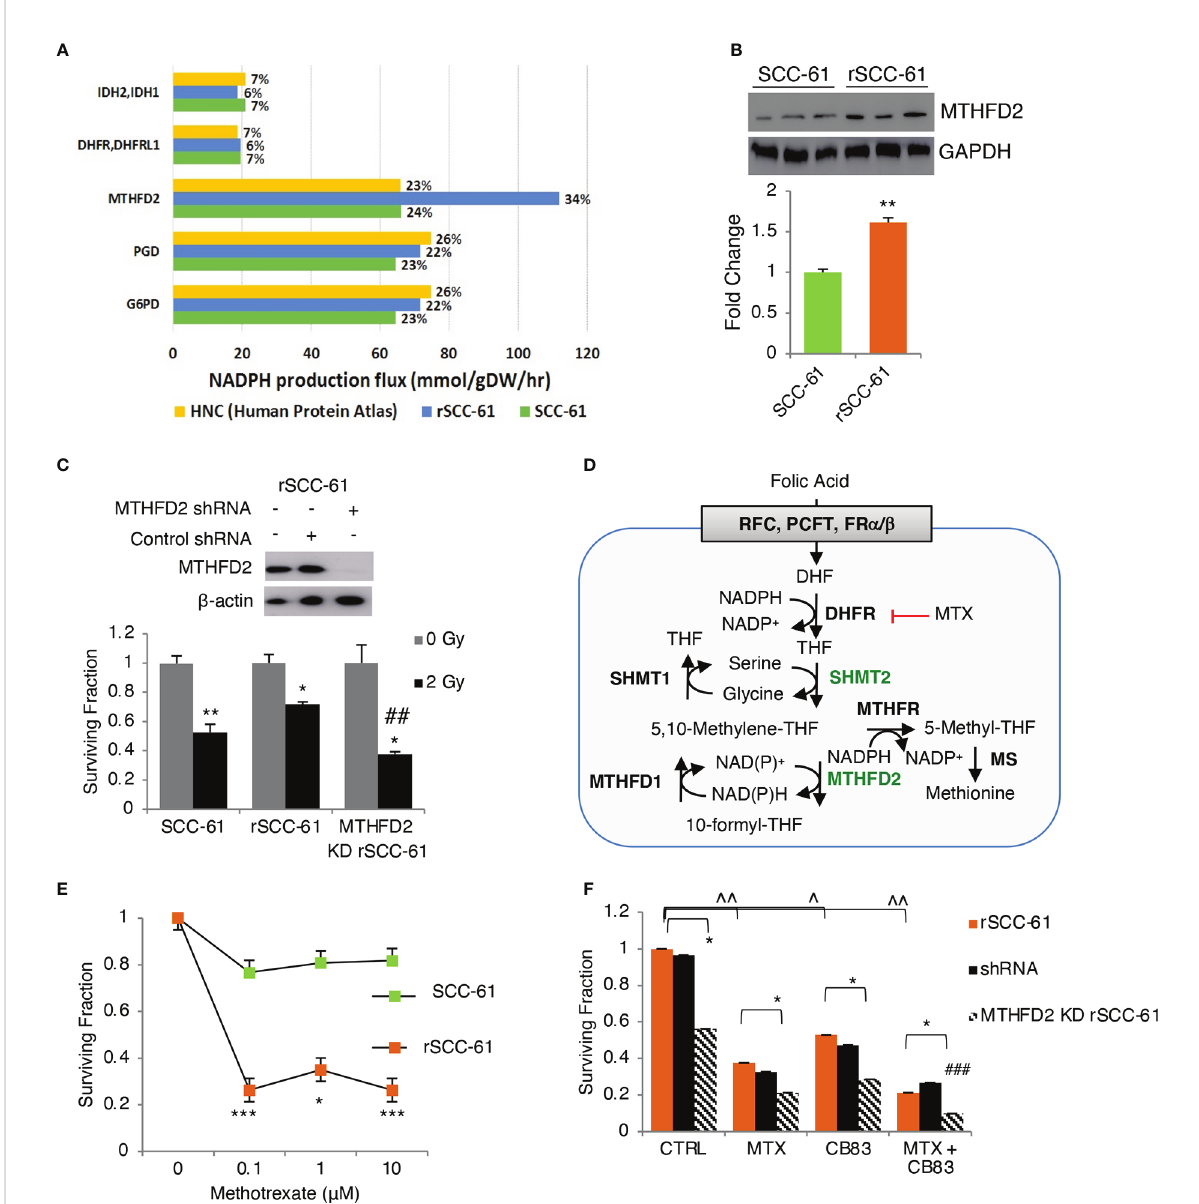
FIGURE 3 Flux balance analysis predicts MTHFD2 as key contributor to NADPH levels in radiation resistant cells. (A) Flux balance analysis of rSCC-61 and SCC-61 cells and HPV-negative HNSCC data extracted from the Human Protein Atlas identi fi es 7 genes: MTHFD2, PGD, G6PD, DHFR/DHFRL1 and IDH2/3 as contributing 84-90% of cellular NADPH production. (B) Western blot analysis con fi rms increased MTHFD2 expression in rSCC-61 cells compared to SCC-61 cells. (C) (upper) Western blot analysis of MTHFD2 in rSCC-61, rSCC-61 control shRNA and MTHFD2 shRNA lysates con fi rms selective knockdown (KD) of MTHFD2 in rSCC-61 cells; (lower) Clonogenic assay after 2 Gy irradiation of SCC-61, rSCC-61 and MTHFD2 KD rSCC-61 cells showing MTHFD2 depletion sensitizes radiation resistant cells to irradiation (*denotes statistical signi fi cance of radiation response relative to untreated cells for each group, and ## denotes statistical signi fi cance of radiation response in MTHFD2 KD rSCC-61 cells relative to rSCC-61 control shRNA; p values * 0.01-0.05 and ## 0.01-0.001, n=3). (D) Schematic of 1-C metabolism contribution to NADPH. (E) Clonogenic assay showing treatment with 0 – 10 m M methotrexate (MTX) decreases rSCC-61 cell survival more signi fi cantly than SCC-61 cells. Statistical signi fi cance is relative to untreated control ( p values * 0.01-0.05, *** <0.001, n=3). None of the SCC-61 treated conditions are signi fi cant compared to untreated control. (F) Clonogenic assay in rSCC-61, rSCC-61 control shRNA and MTHFD2 KD rSCC-61 demonstrating decreased cell survival by treatment with 0.1 m M MTX and 10 m M CB83 (G6PD inhibitor) and MTX and CB83 combined.